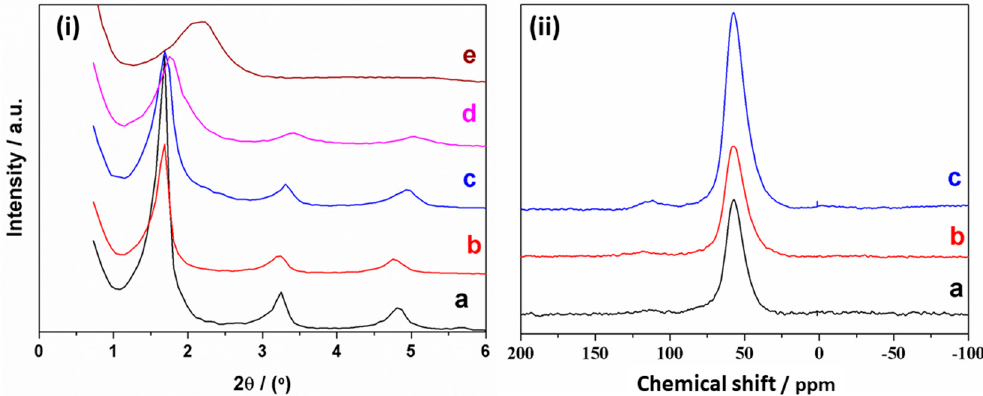
Figure 6. ( i ) Low-angle XRD patterns of samples ( a ) UVM-L16 and the Al modified solids Al-UVM-L16 with different Al content (Si/Al real molar ratio): ( b ) 22, ( c ) 7, ( d ) 5, and ( e ) 3. ( ii ) 27 Al MAS NMR spectra of Al-UVM-L16 samples with different Al content (Si/Al real molar ratio): ( a ) 22, ( b ) 7, and ( c ) 5.